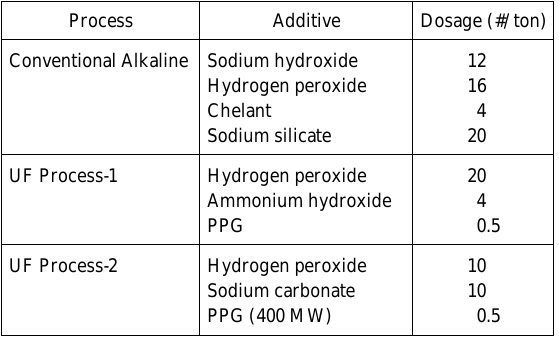
Table 2 Comparison between Recipes and Reagent Consumption for Conventional and the Developed Deinking